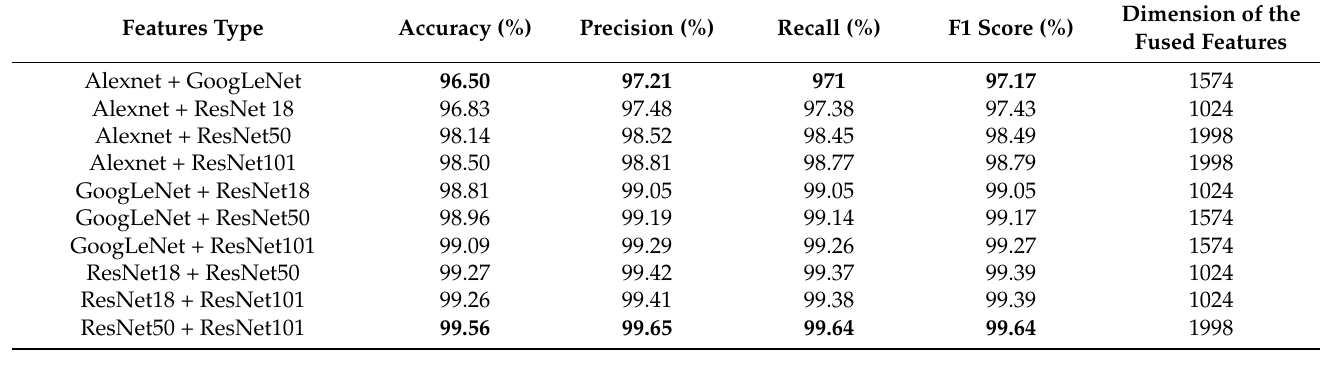
Table 7. Results of CCA concatenation fusion method (bold font shows the best performance).